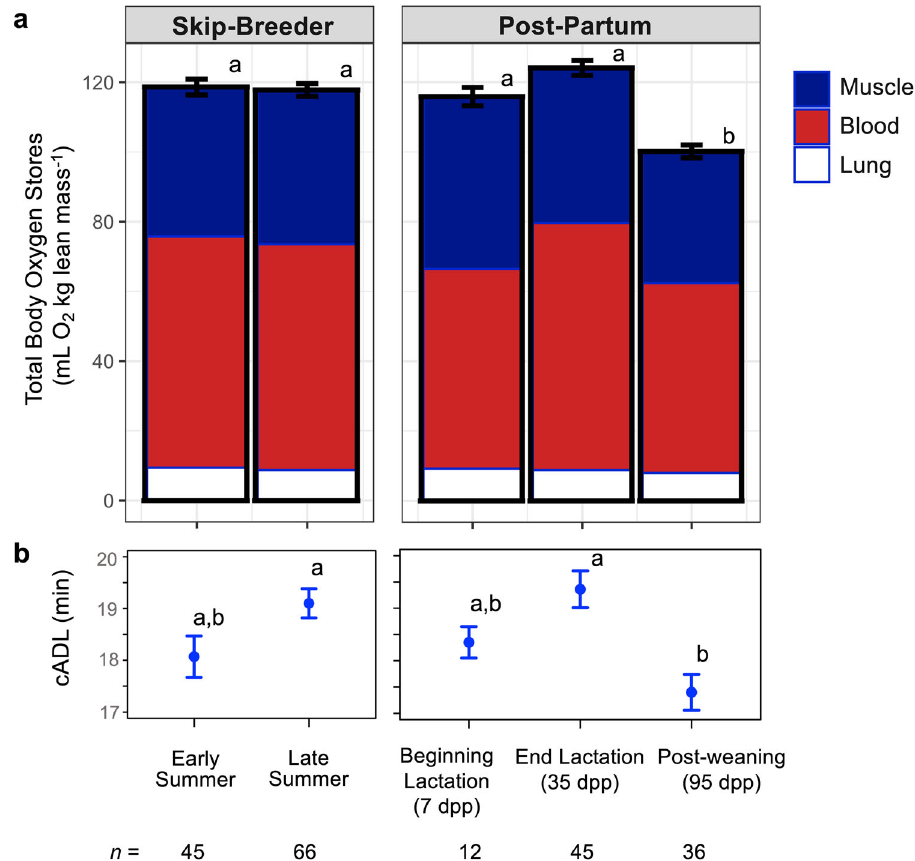
Fig. 5 Decreased TBO 2 and cADLs after lactation. Mean ± SE ( a ) Weddell seal total body oxygen stores scaled to lean body mass (and divided into muscle, blood, and lung compartments) and b the calculated aerobic dive limit declined signi fi cantly by the end of the austral summer only in post-partum females. Statistical signi fi cance was detected using Linear Mixed-Effect models and post-hoc comparisons with Bonferroni correction; Different letters = signi fi cant difference in TBO 2 and the cADL between reproductive